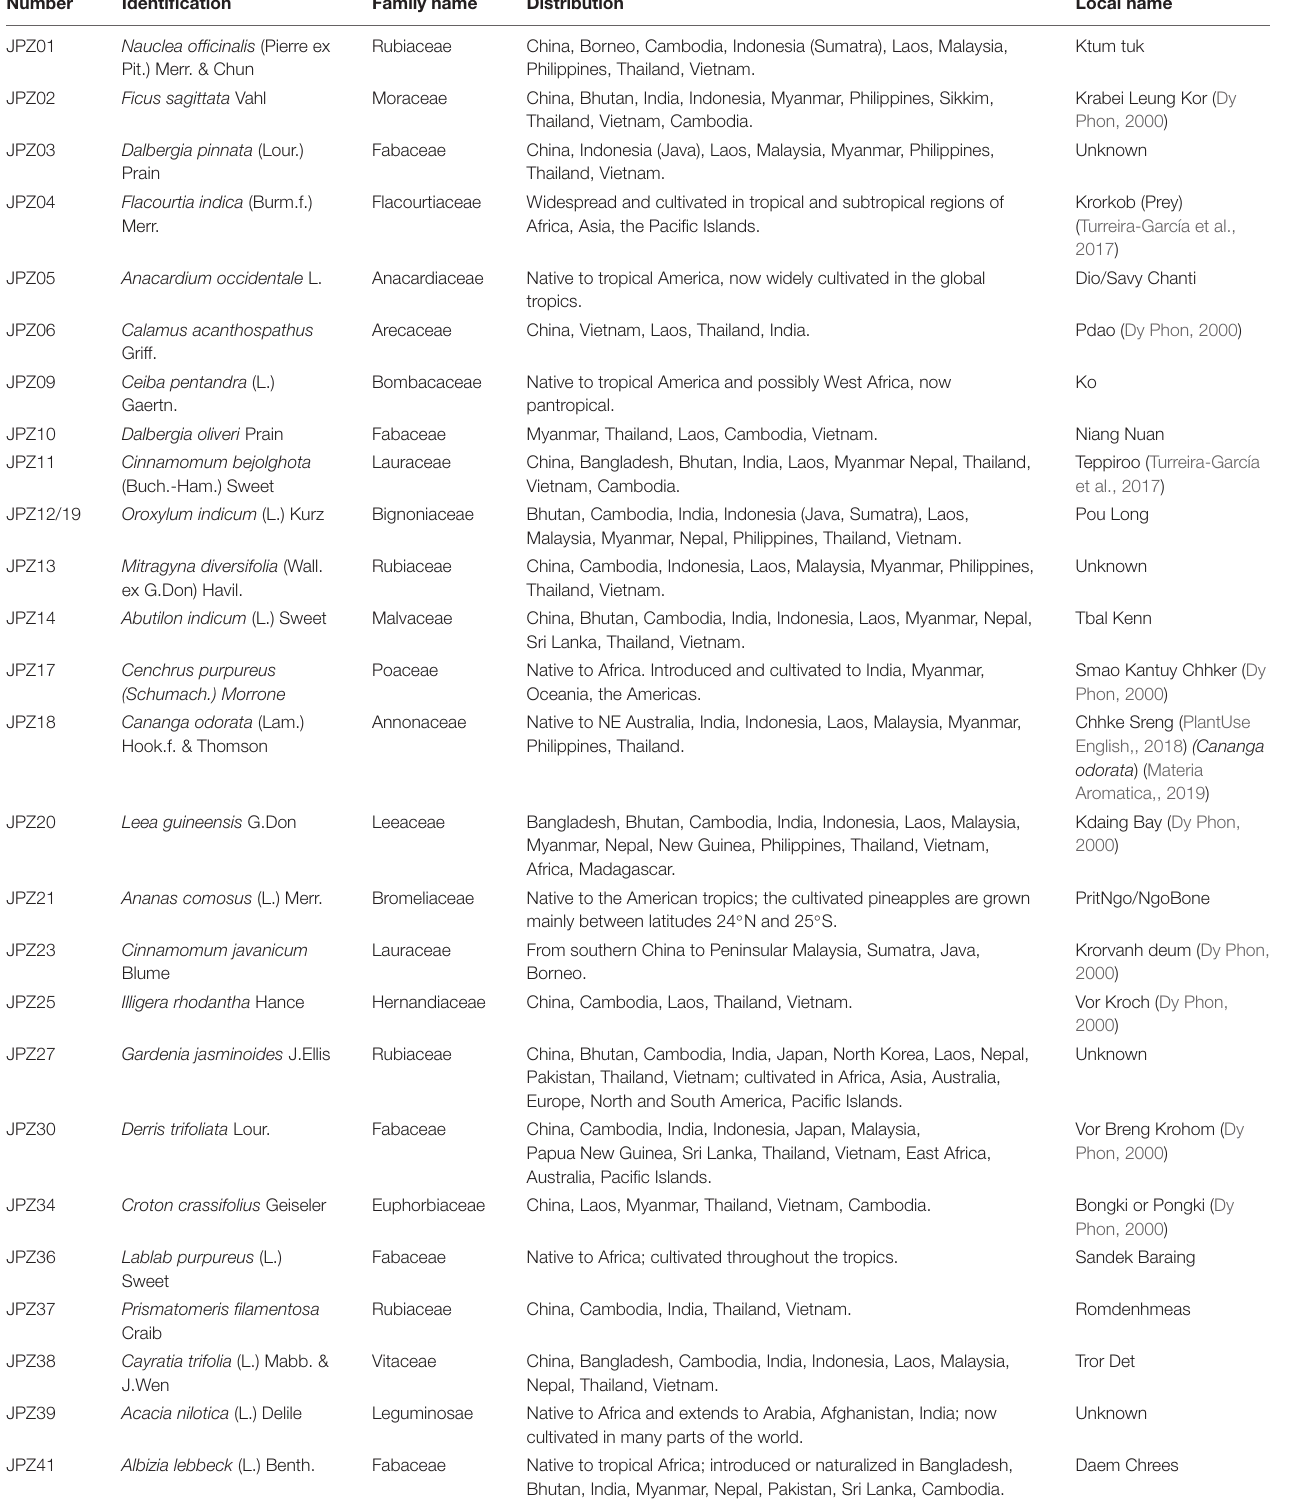
TABLE 2 | Ethnopharmacological information for the 33 medicinal plants of defined